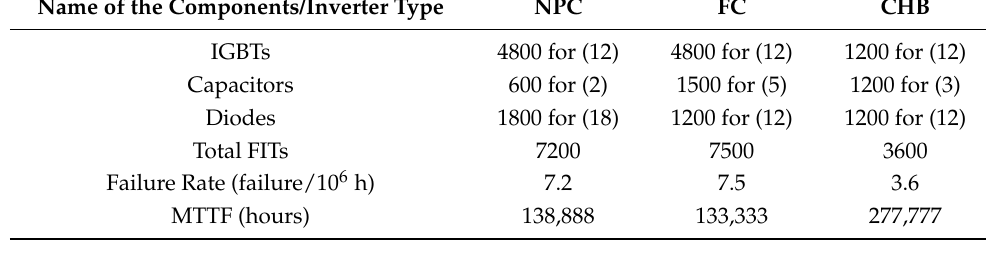
Table 5. The Estimated Mean Time to failure for three conventional Inverters. Name of the Components/Inverter Type